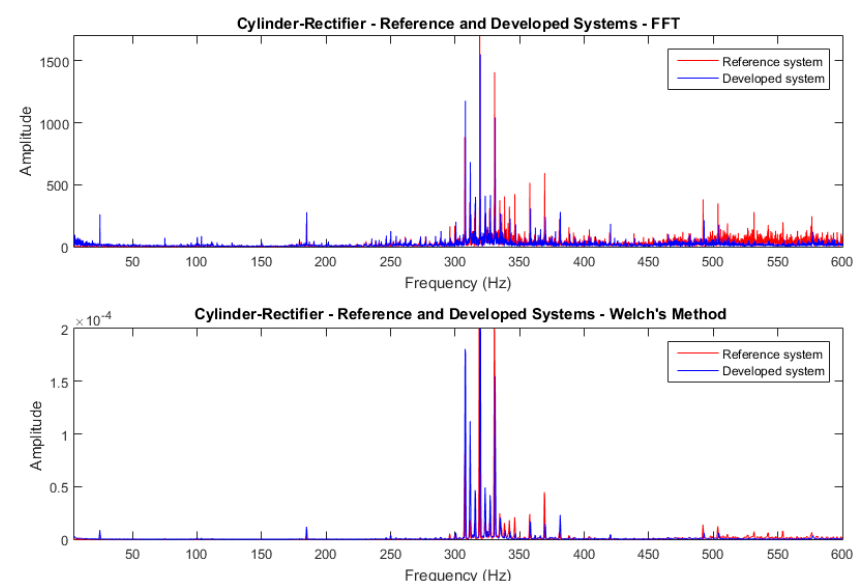
Figure 12. Comparison of vibration signatures obtained from the measurements performed on a cylinder-rectifier machine. The top plot shows the results obtained by applying the FFT. The bottom plot shows the results obtained by applying Welch’s method.